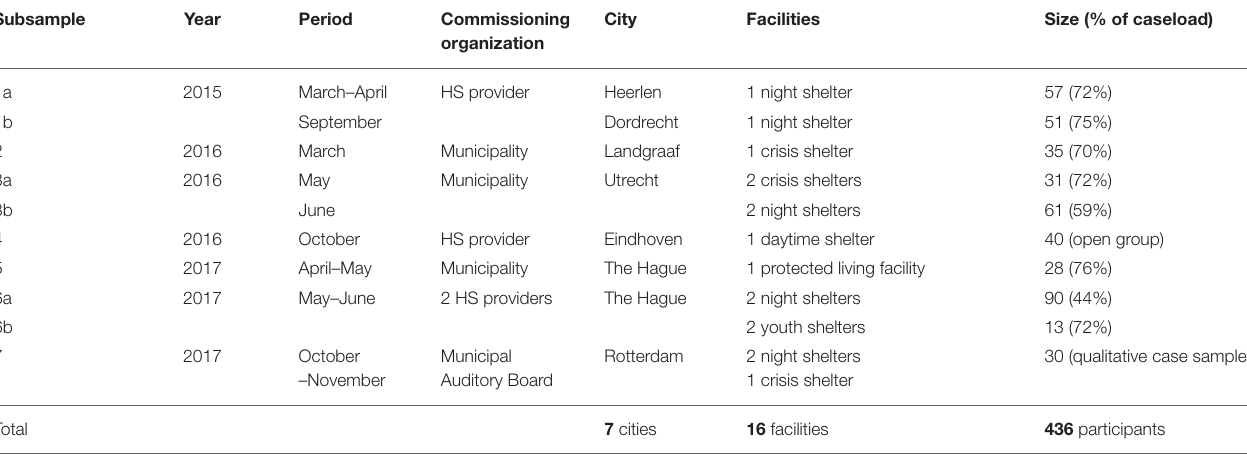
TABLE 2 | Setting